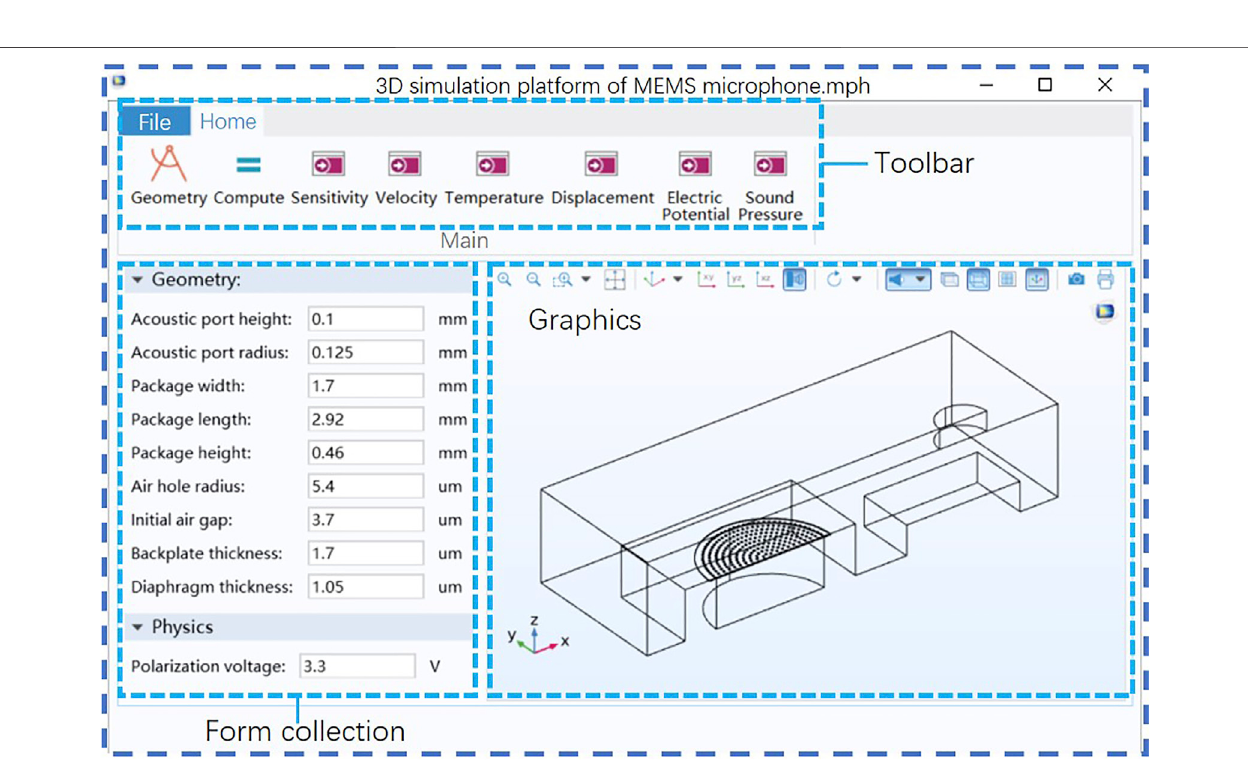
FIGURE 2 | Three-dimensional fi nite element simulation platform for MEMS microphones.